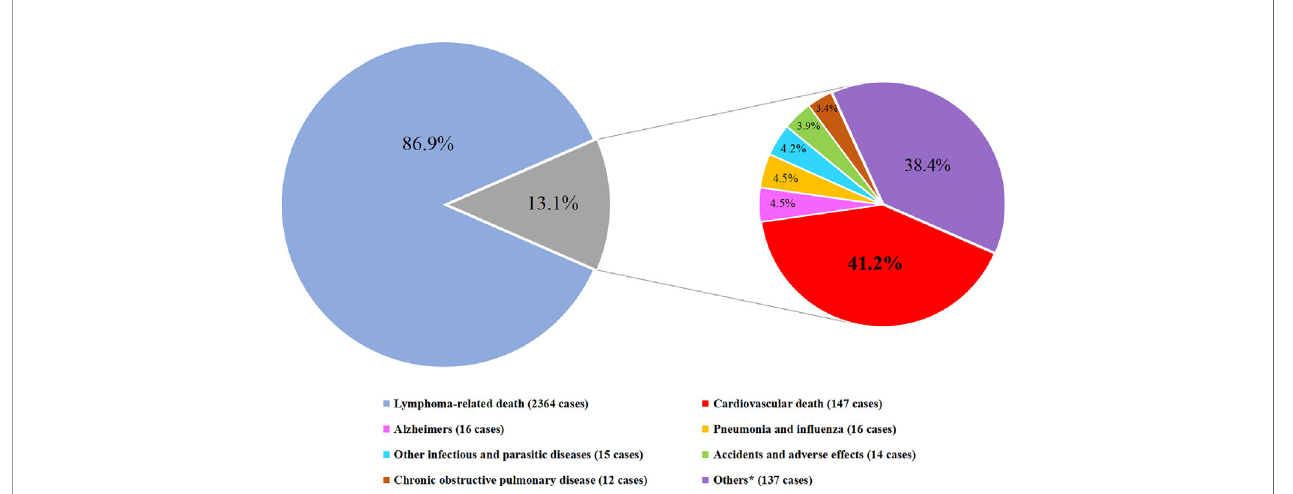
FIGURE 2 | Cause of death distribution in PCNSL patients. (Cardiovascular deaths include diseases of heart, cerebrovascular diseases, hypertension without heart disease, atherosclerosis. Others* include nephritis, nephrotic syndrome and nephrosis, diabetes mellitus, septicemia, chronic liver disease and cirrhosis, stomach and duodenal ulcers, congenital anomalies, symptoms, signs and III-de fi ned conditions, suicide and self-in fl icted injury, and other cause of